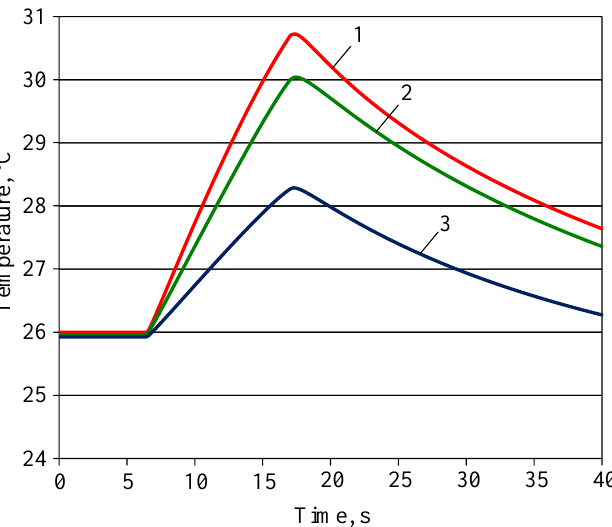
Figure 6. The change in the plant leaf temperature when illumination sources of different power are used (the length of light impulse is 11 s): 1 — change in the plant leaf temperature with 150 W lamps; 2 — 100 W; 3 — 60 W ( p < 0.05, n =